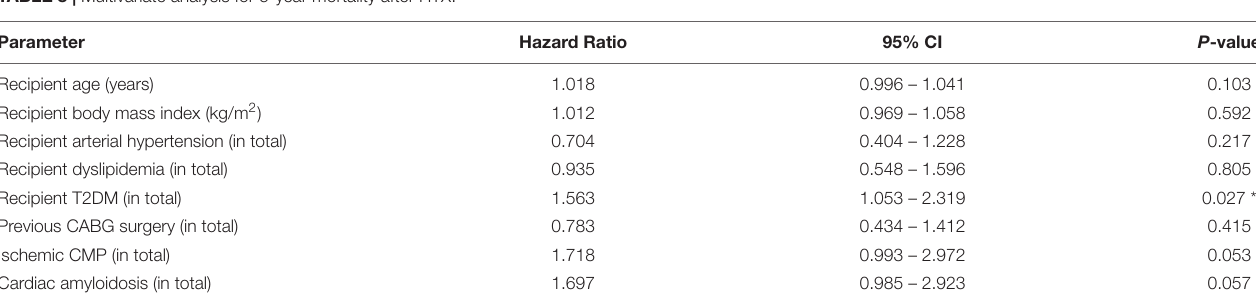
TABLE 8 | Multivariate analysis for 5-year mortality after HTX.